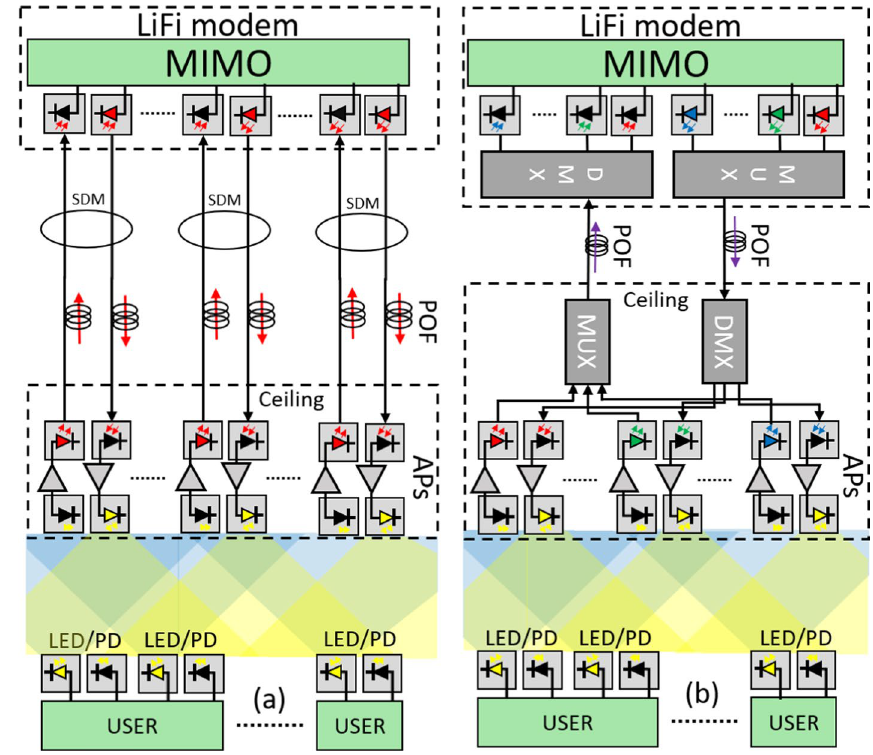
Fig. 14 a SDM and b WDM approach using POF as the fronthaul of